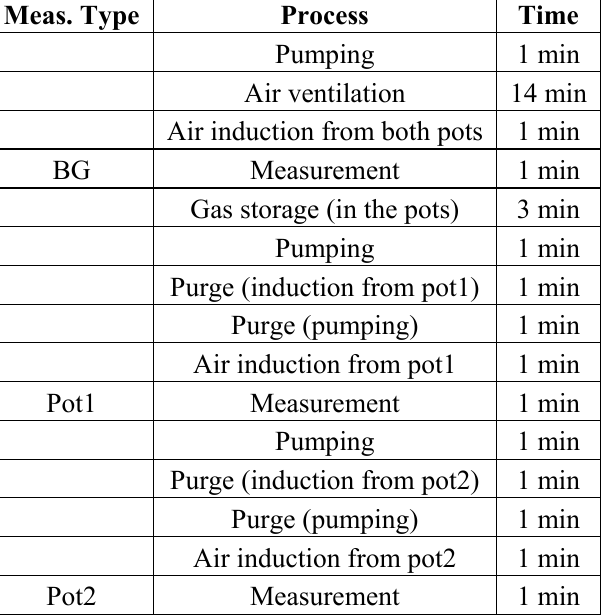
Table 1. Measurement sequence and time setting in this